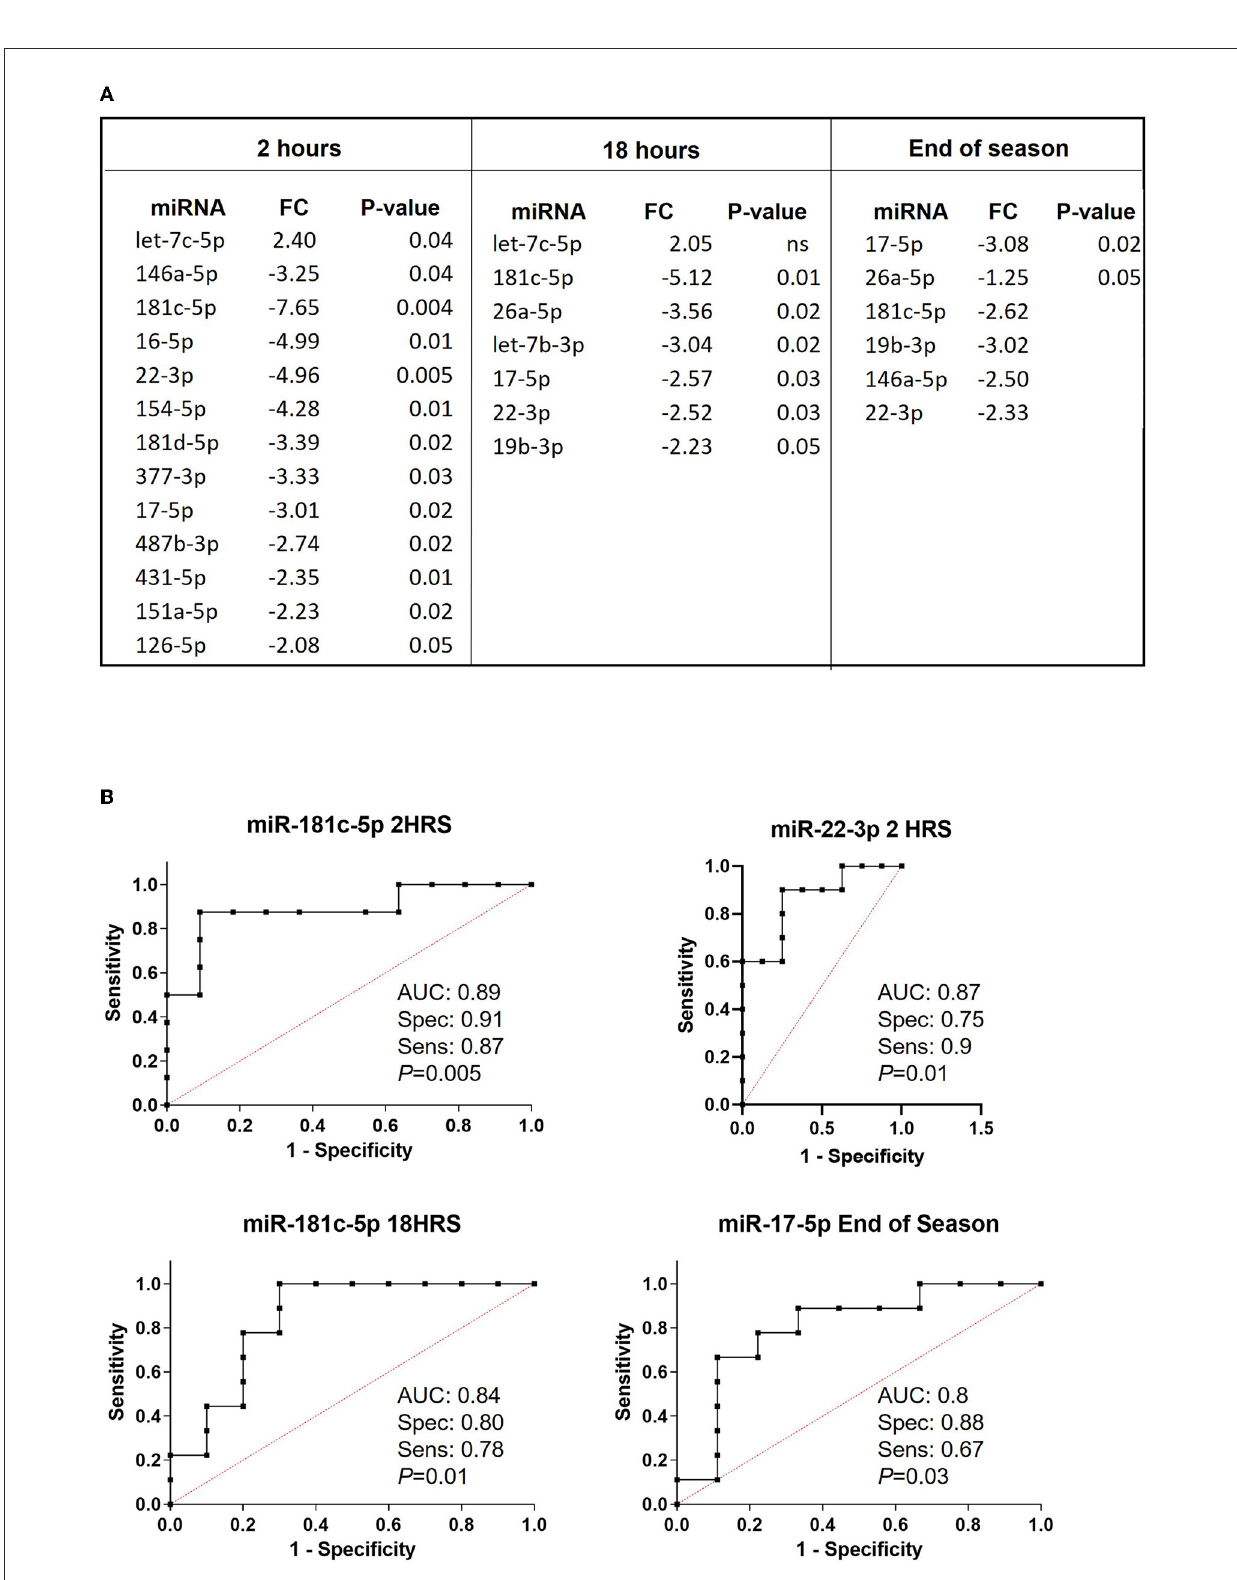
FIGURE3 Relative expression of miRNAs discriminating concussed players from controls at different time points after concussion and at the end of the season. (A) List of differentially regulated miRNAs in concussed players vs. controls at 2h (concussed n = 9, controls n = 11), 18h (concussed n = 9, controls n = 9) after concussion, and at the end of the season (concussed n = 9, controls n = 9). FC: fold change expressed as 2 − 11 Ct . P -values are reported in each table. Ns: non-statistically significant. (B) ROC analysis graphs for the most dysregulated miRNA with the lowest p -value at each timepoint. AUC, sensitivity, specificity and exact p -values are indicated in the